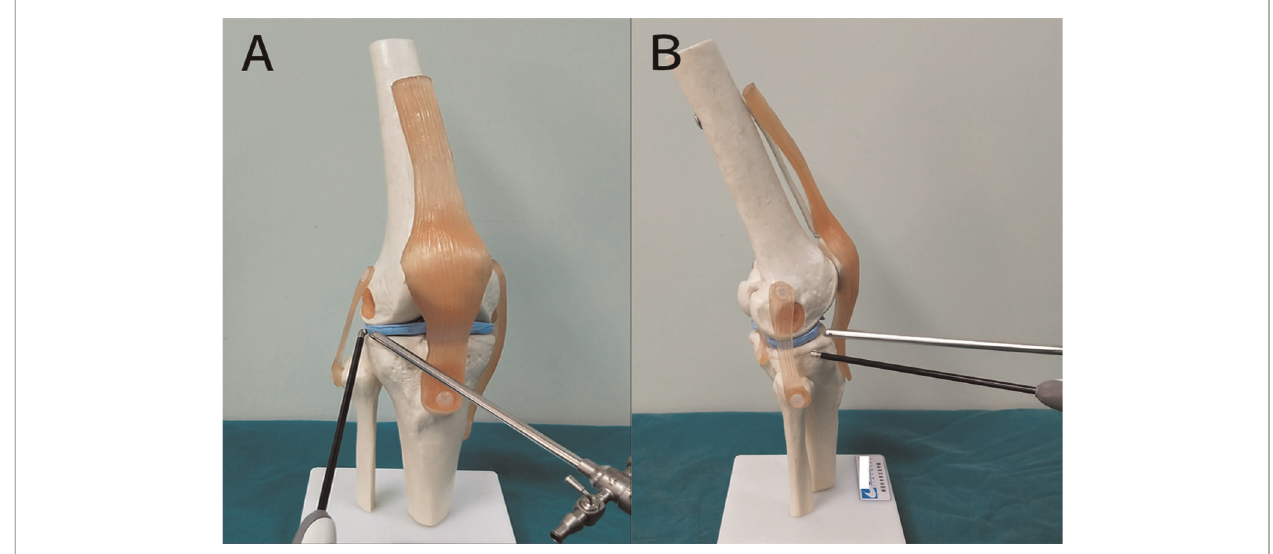
FIGURE 3 | Model of an auxiliary extreme lateral approach combined with a conventional anterolateral approach in the knee. ( A ) anterolateral view, ( B ) lateral views.